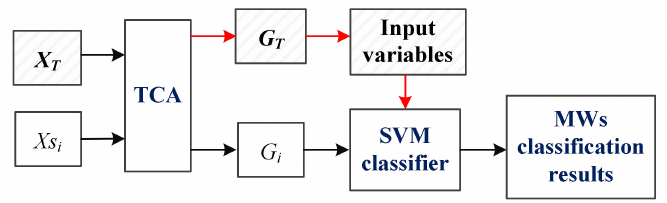
Figure 5. Implementation of Method 3.